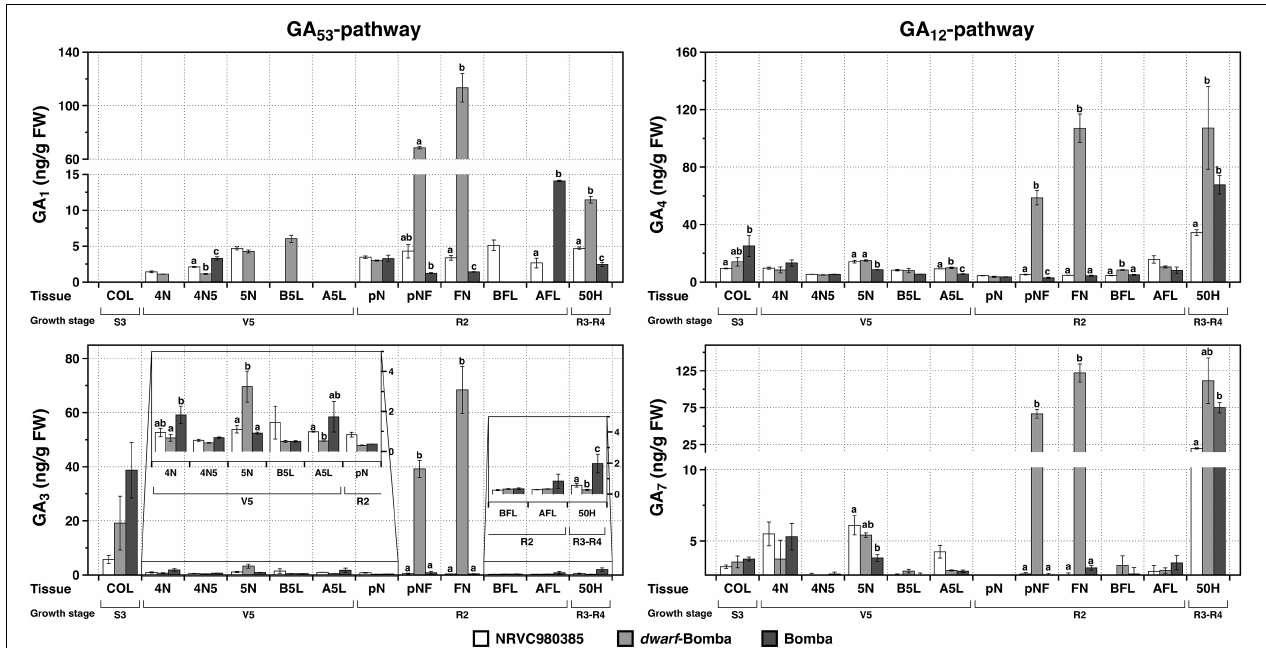
FIGURE 5 | Content of the bioactive gibberellins (GA 1 , GA 3 , GA 4 , and GA 7 ) in the different tissues for the three analyzed varieties: NRVC980385, dwarf- bomba, and Bomba. COL, coleoptile; 4N, 4th node; 4N5, internode between 4th and 5th node; 5N, 5th node; B5L, basal part of the 5th leaf; A5L, apical part of the 5th leaf; pN, node previous to the flag leaf node; pNF, internode between flag leaf and previous leaf; FN, flag leaf node; BFL, basal part of the flag leaf; AFL, apical part of the flag leaf. Columns correspond to mean ± SEM of 3 replicates, and letters above bars indicate significant differences between varieties for each tissue